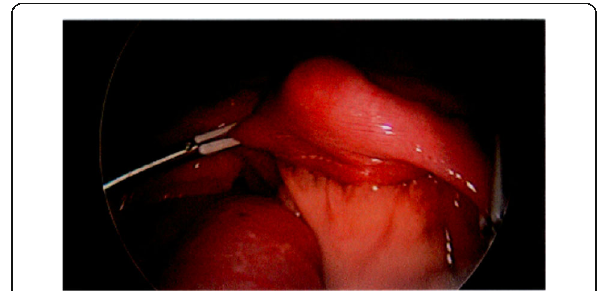
Fig. 3 Transition point with decompressed loops of bowel distally. At the level of the mid-jejunum, kinking of the small bowel was noted, without involvement of the mesentery or evidence of adhesions. Immediately distal to this point, the bowel was entirely decompressed, without evidence of poor perfusion